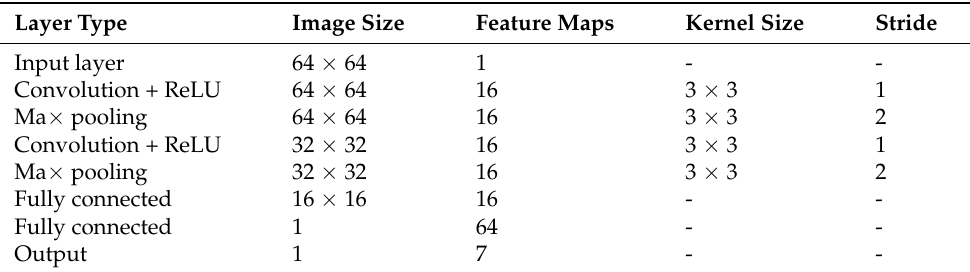
Table 2. The settings of the